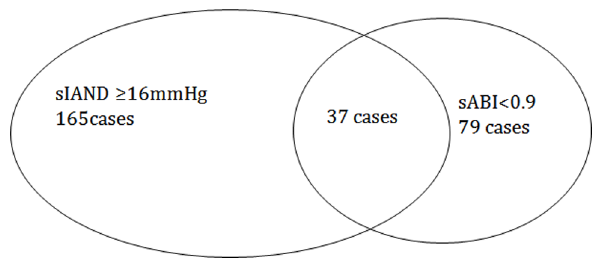
Figure 1. The relationship between increased sIAND and abnormal